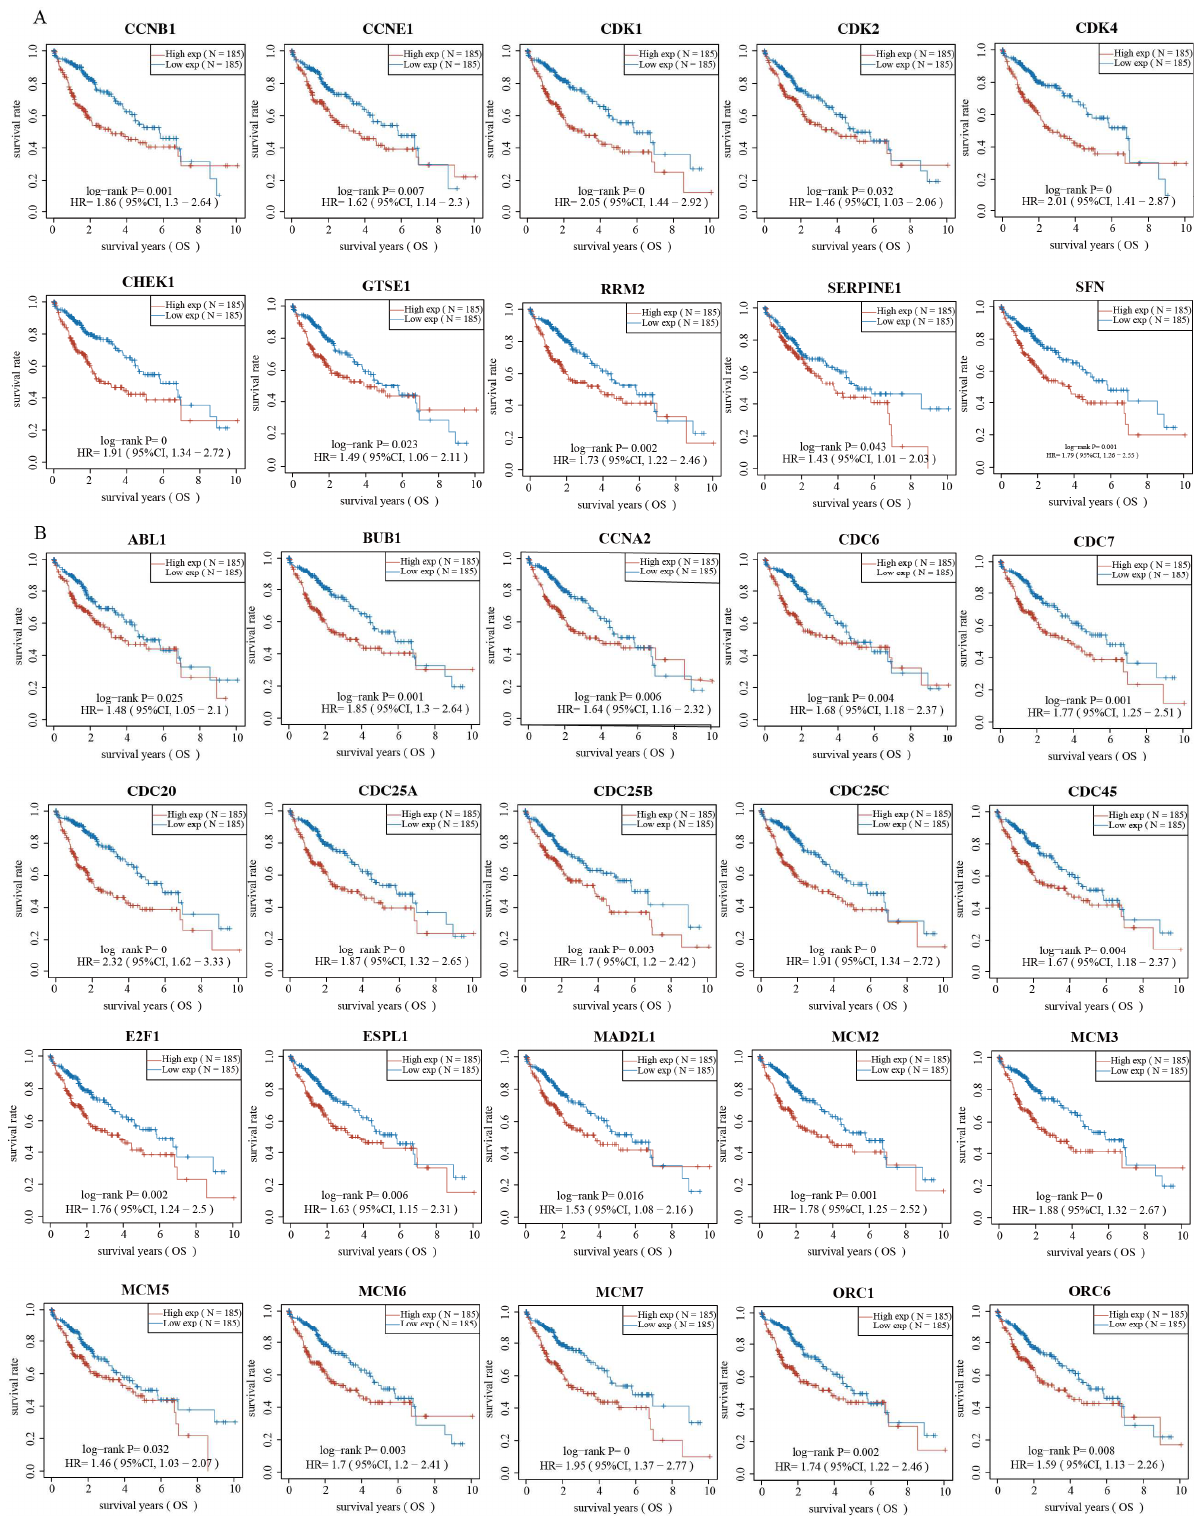
Figure 3. Validation of genes in p53 signaling pathway and cell cycle associated with the prognosis of HCC. ( A ) The Kaplan–Meier curve of overall survival of patients with different expression of genes in p53 signaling pathway. ( B ) The Kaplan–Meier curve of overall survival of patients with different expression of genes in cell cycle.